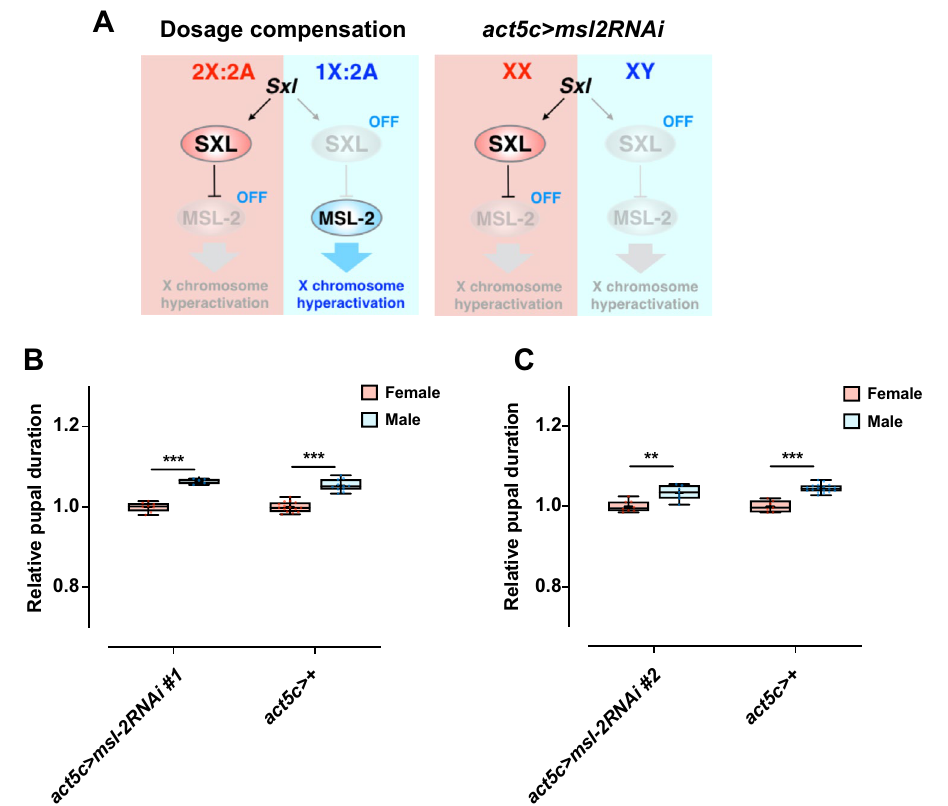
Figure 3. Alteration of msl-2 expression does not affect the protogyny phenotype. ( A ) Schematic presentation of the dosage compensation pathway and effect of msl-2 expression alteration. ( B , C ). Effect of act5c > msl-2 RNAi #1 ( B ) and act5c > msl-2 RNAi #2 ( C ) on the protogyny phenotype . Whiskers indicate minimum and maximum values (*** p < 0.001, ** p < 0.01 by Student’s unpaired t